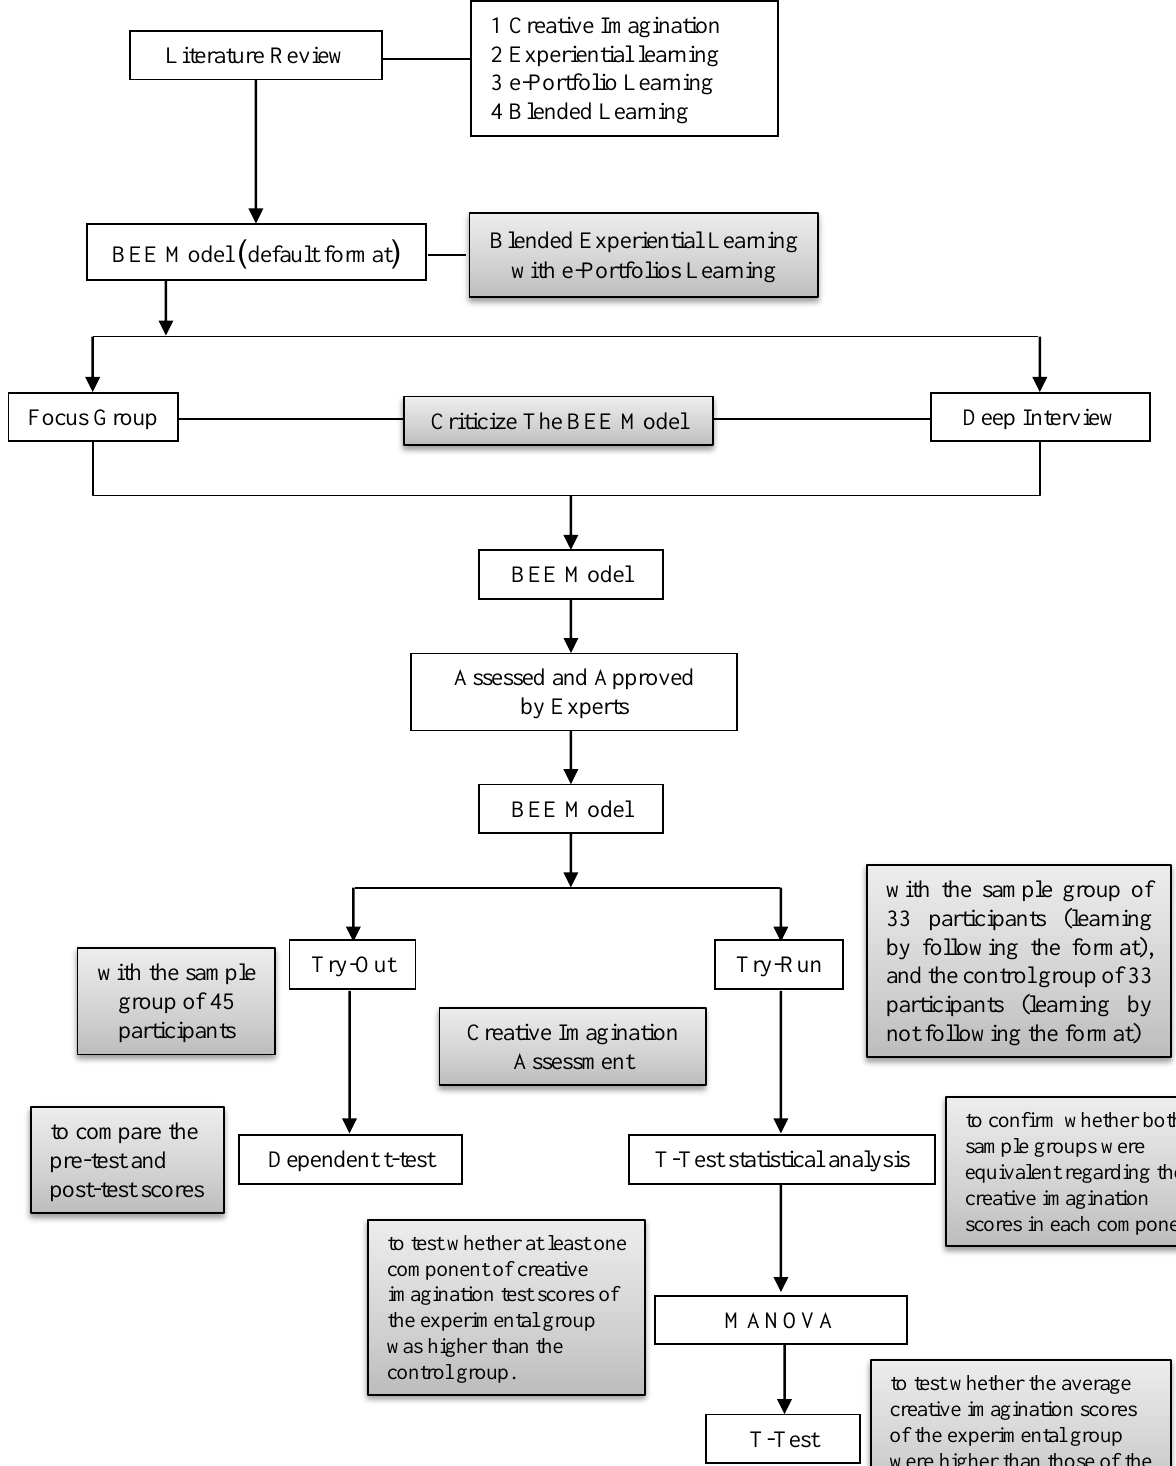
Figure 1. The flowchart to show the research